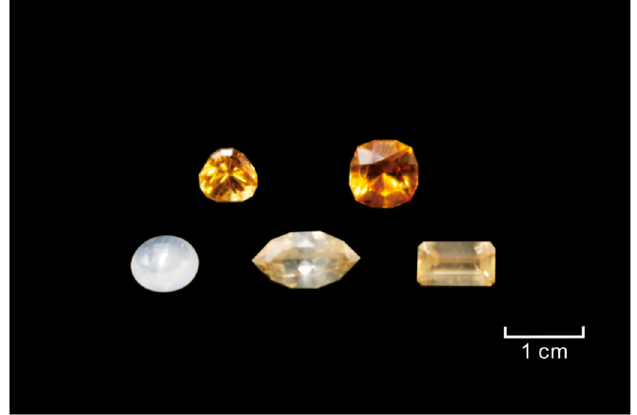
Figure 2. Samples of scheelite from Pingwu, Sichuan.